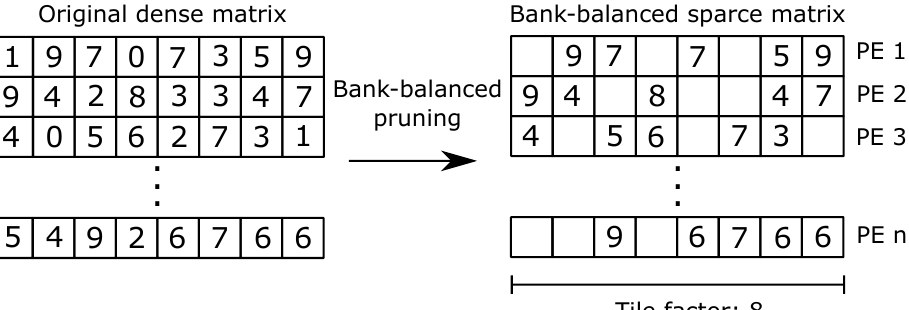
Figure 4. Bank-balanced pruning in MobileNet